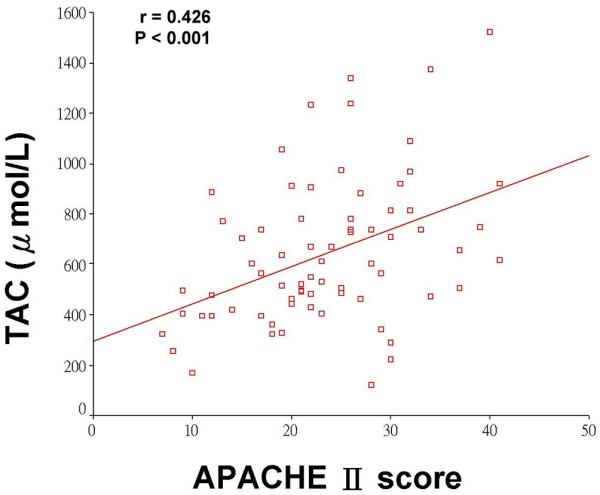
Correlation between serum TAC and APACHE II score in patients with severe sepsis. A total of 73 patients were included in the study. APACHE, Acute Physiology and Chronic Health Evaluation; TAC, total antioxidant capacity.